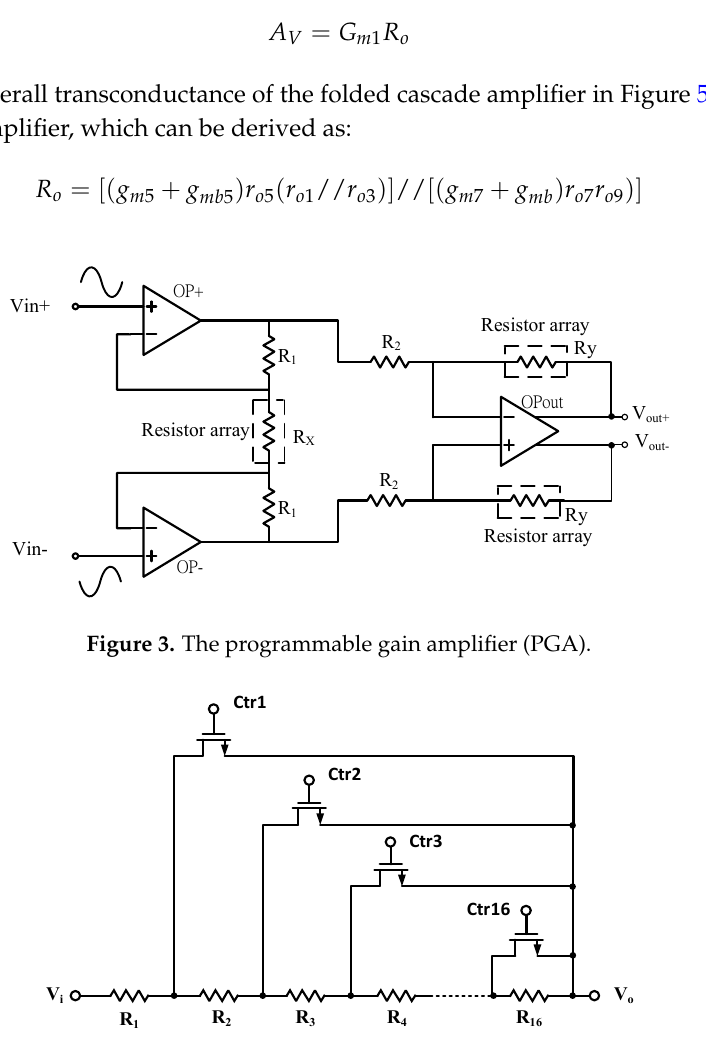
Figure 4. The on-chip switch resistor array in the PGA.